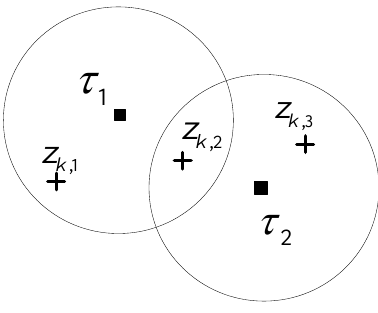
Figure 1. An example of a cluster for two tracks and three measurement.